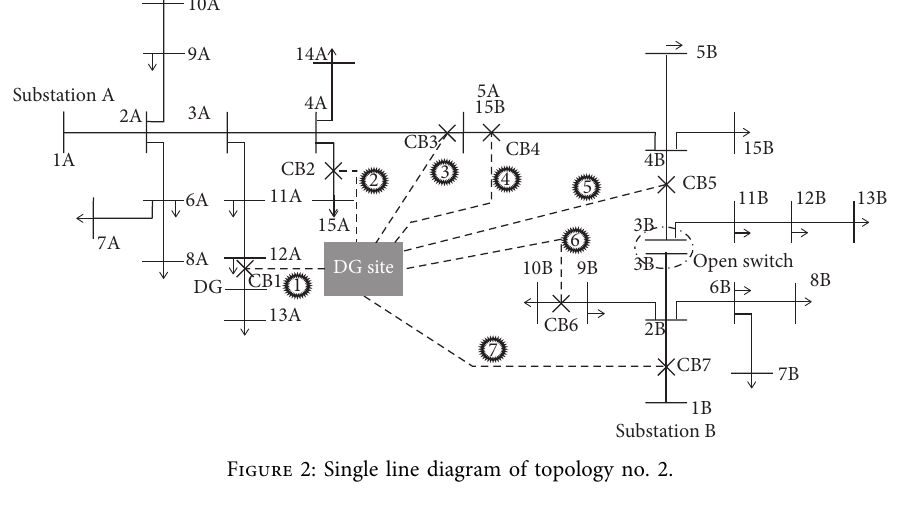
Figure 2: Single line diagram of topology no. 2.